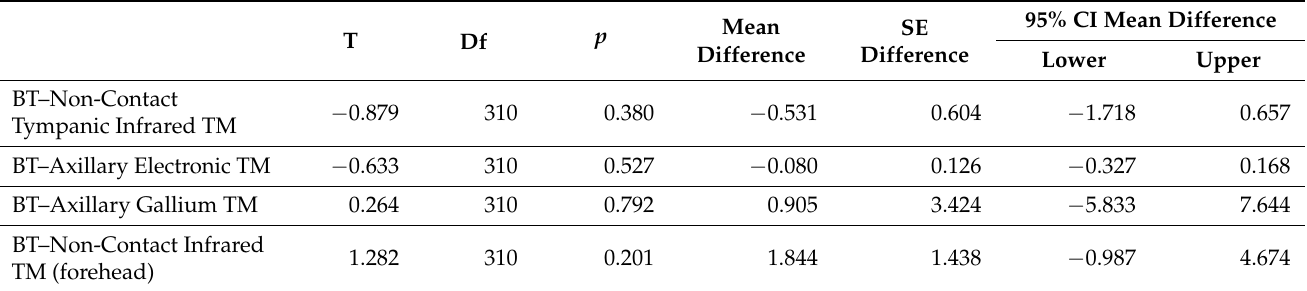
Table 7. Independent samples t -test: bed location and environmental